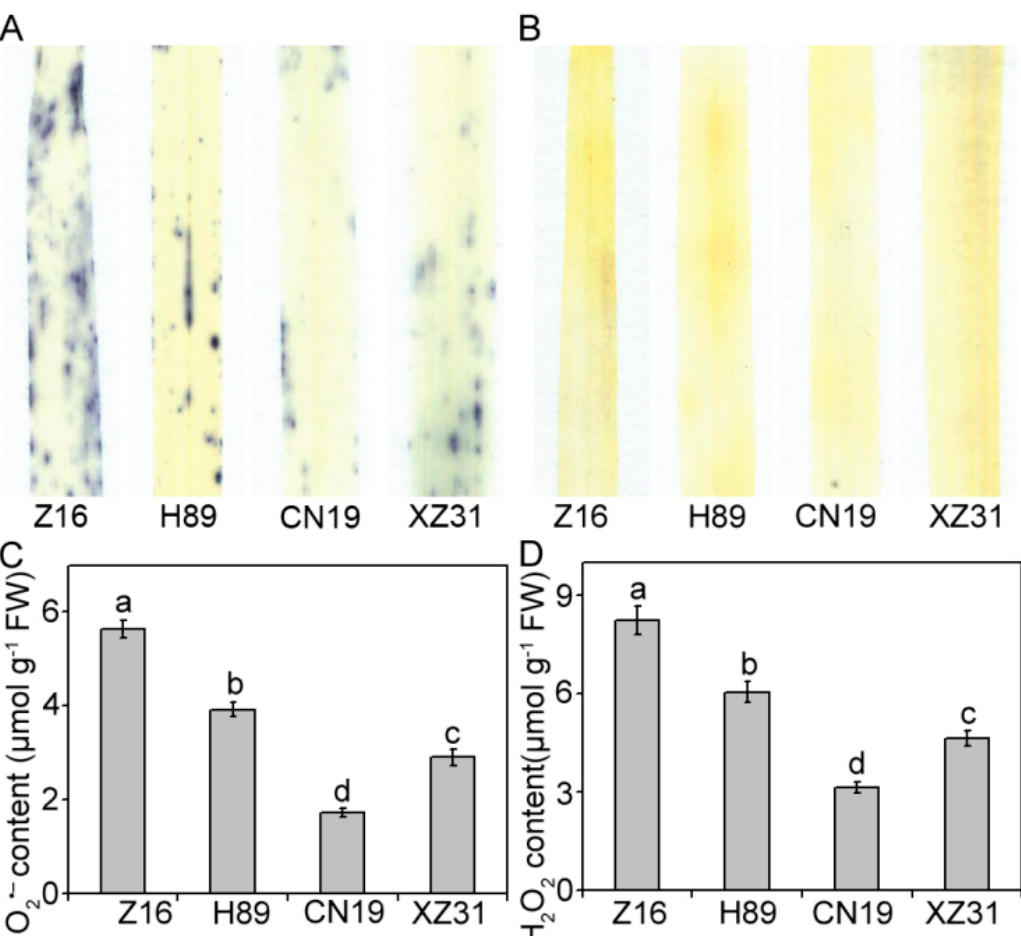
Figure 6. Measurement of reactive oxygen species (ROS) in Z16, H89, CN19, and XZ31. Histochemical analysis for superoxide anion radicals (O 2 • – ) and hydrogen peroxide (H 2 O 2 ) by nitro blue tetrazolium (NBT) ( A ) and 3,3-diaminobenzidine (DAB) ( B ) staining, respectively. Then, superoxide anion radicals (O 2 • – ) production rate ( C ) and hydrogen peroxide (H 2 O 2 ) content ( D ) were determined. Values are expressed as the means ± SD ( n = 4). Different letters indicate significant differences at p < 0.05 level (Duncan’s multiple range test). Z16, H89, CN19, and XZ31 present accessions of Triticum